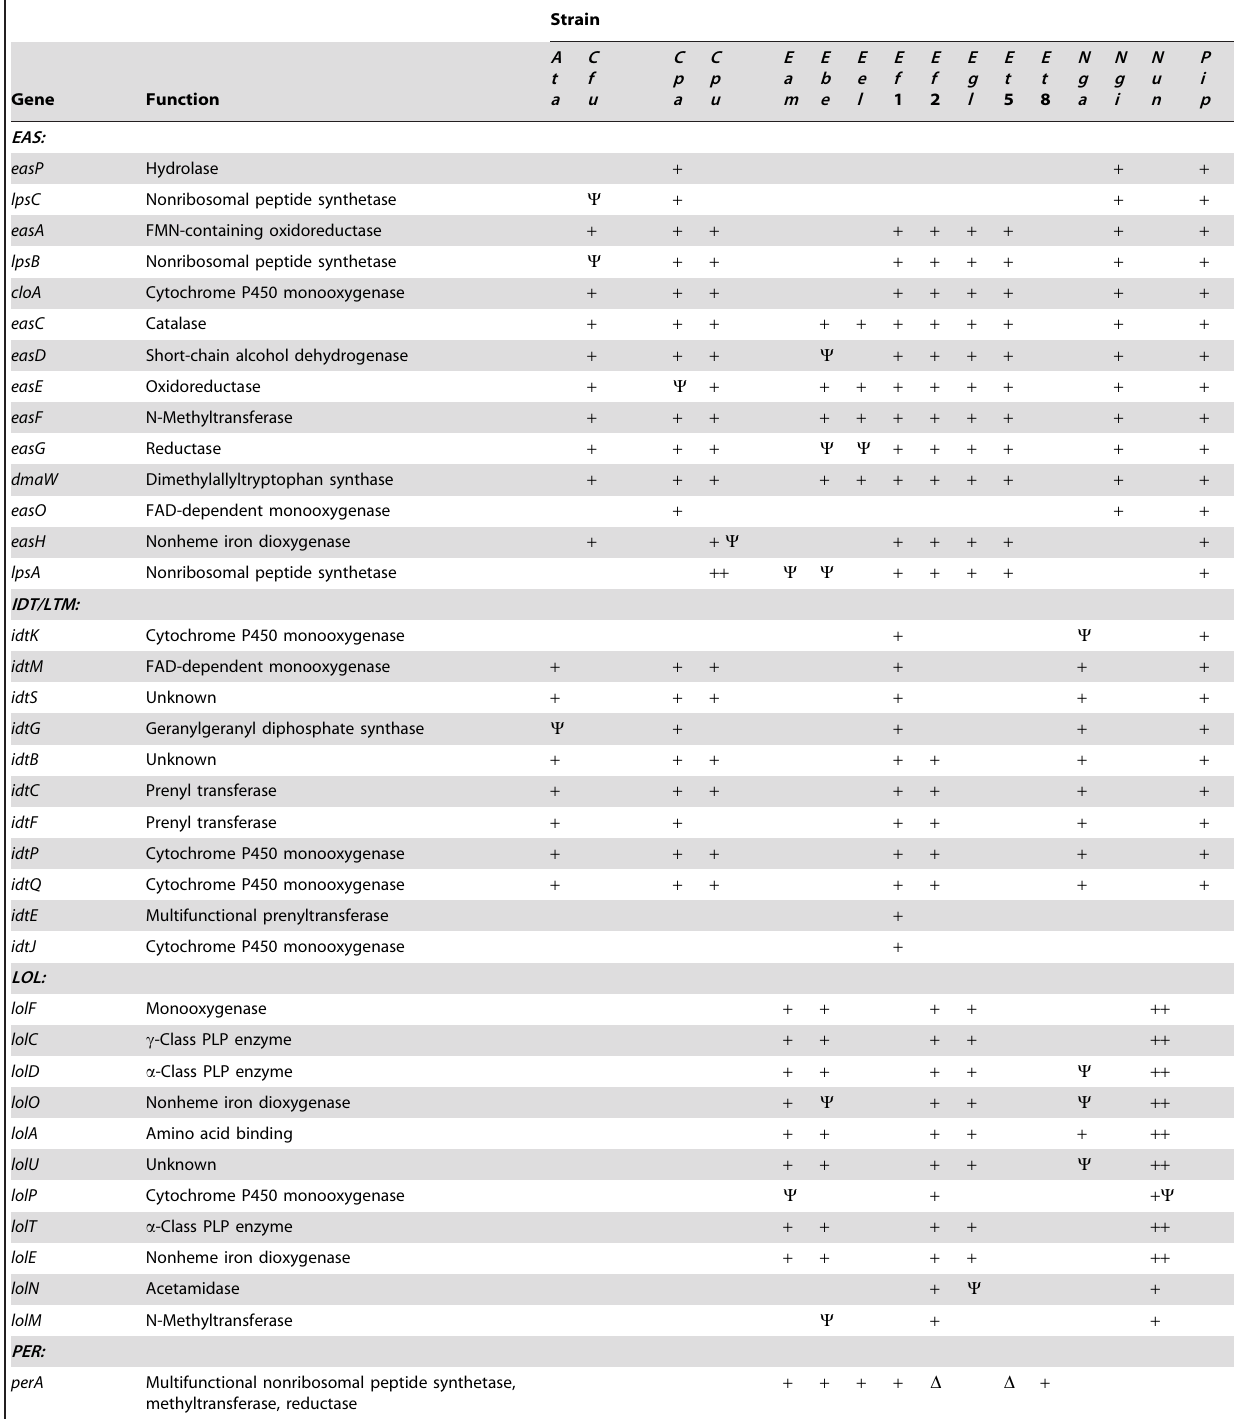
Table 5. Alkaloid biosynthesis genes in sequenced isolates. a